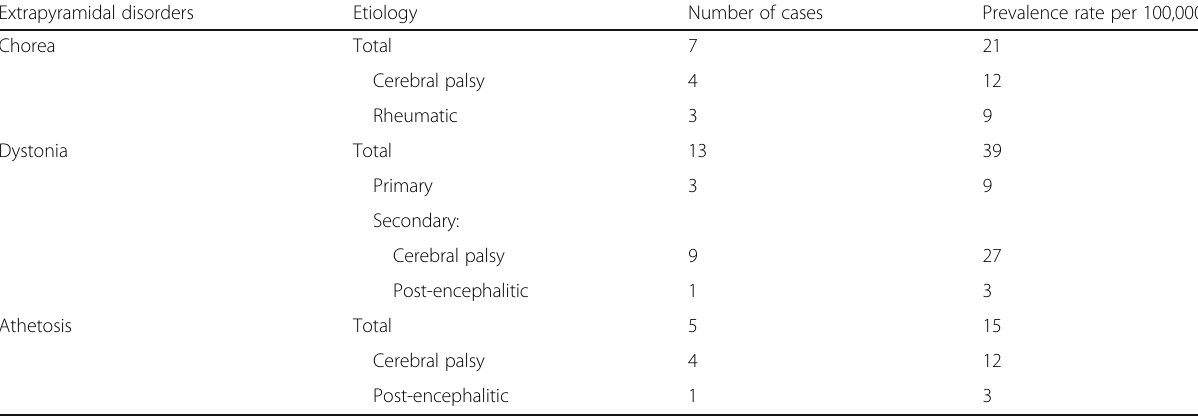
Table 1 Prevalence and etiology of dystonia, chorea, and athetosis among studied population per 100,000 in Al Quseir City, Egypt Extrapyramidal disorders